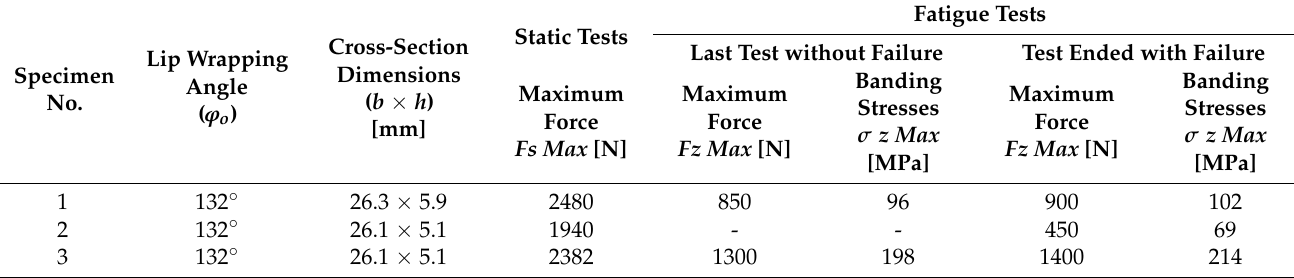
Table 2. Results of static bending tests and fatigue loading tests for the lip compensating circumferential backlash in a gear